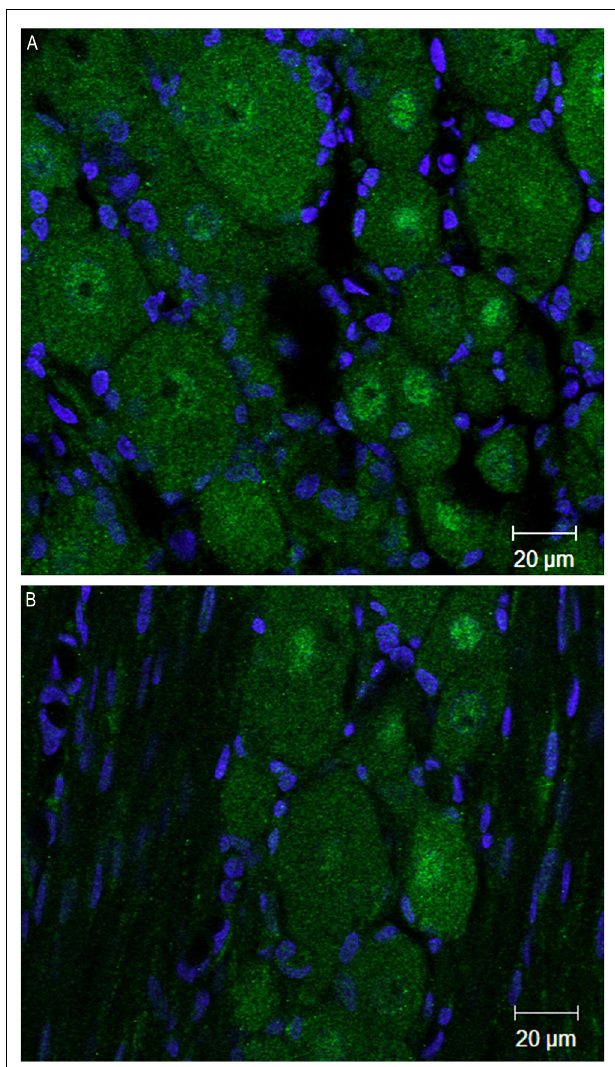
FIGURE 5 | DNMT3b transcript expression remains exclusively neuronal after peripheral nerve injury. Immunohistochemisry was performed on sections obtained from DRG ipsilateral to the peripheral injury in two SNI rats 1 week post-surgery. (A,B) are two examples of images obtained by staining the DRG sections with DNMT3b (green) antibody and DAPI (blue). Note that, similar to the naïve tissue, DNMT3b expression is ubiquitous in neurons, but absent from